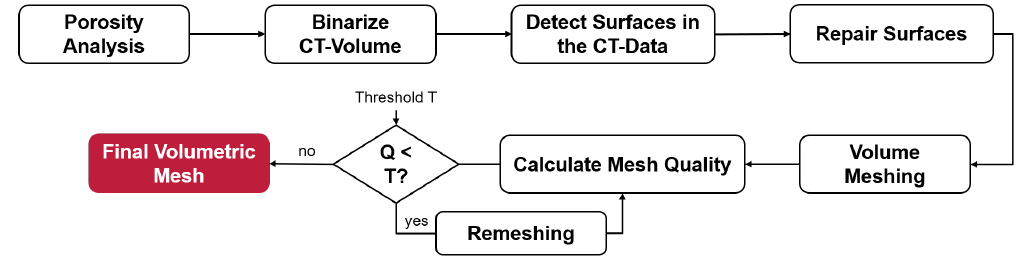
Figure 3. Flowchart of the proposed FE-meshing algorithm.